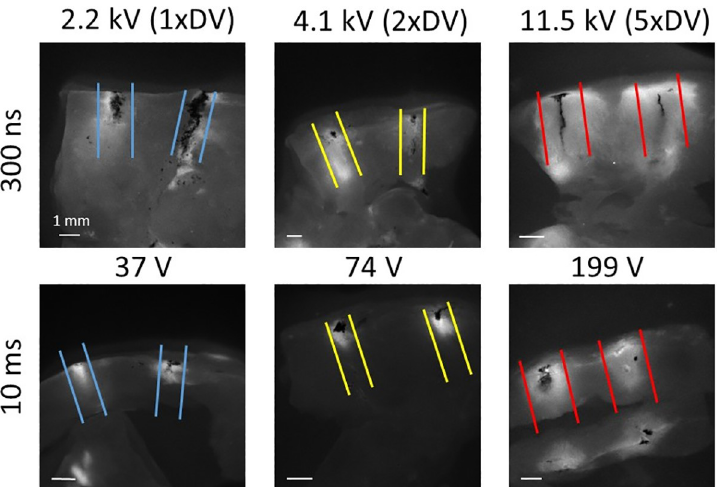
Fig 6. PI staining of tissue cross sections for shocks of different field strength. A) Representative examples for PI staining in the needle plane, for both 300 ns (top) and 10 ms (bottom). The parallel lines denote the isolines for 3 (blue), 6 (yellow), and 15 (red) E max,DV . B) Safety factor for the cross sections for 300 ns (n = 18) and 10 ms shocks (n = 17). The averages are denoted with an “x”, the box shows the first quartile to the third quartile with the median intersecting the box, and the whiskers denote the maximum and